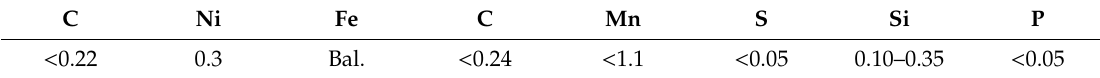
Table 2. Composition of St3SU carbon steel used in the construction of Model I MH-DCFC (wt.%).